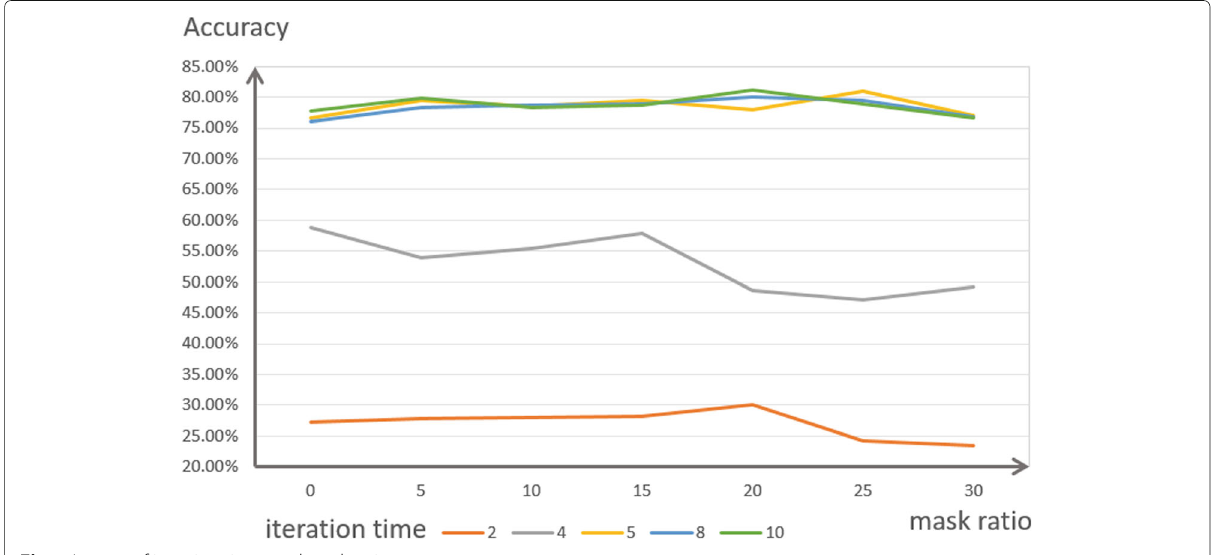
Fig. 5 Impact of iteration times and mask